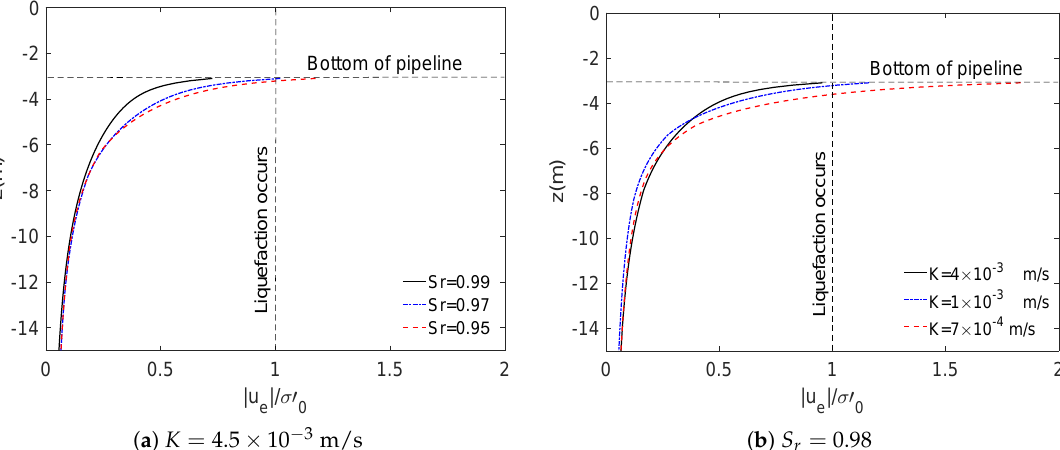
Figure 8. Distribution of the excess pore pressure ( | u e | / σ (cid:48) section through the center of the pipeline for different soil